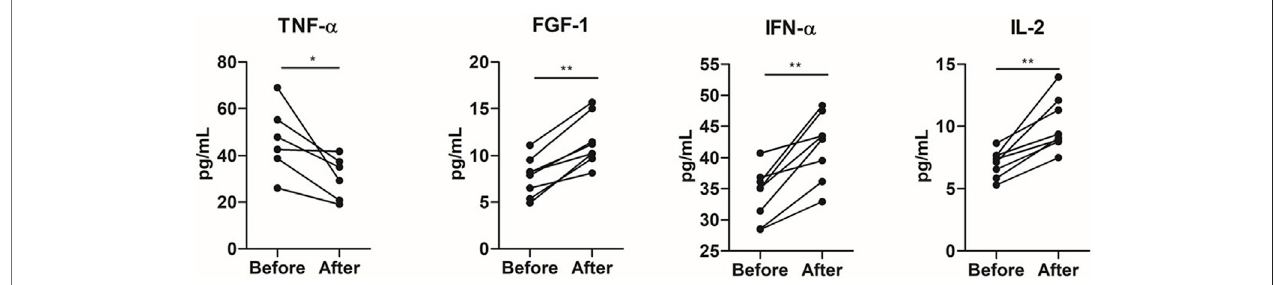
FIGURE 3 | Impact of 8 weeks of multimodal exercise training on systemic cytokine levels of institutionalized older adults. * p < 0.05; ** p < 0.01; *** p <